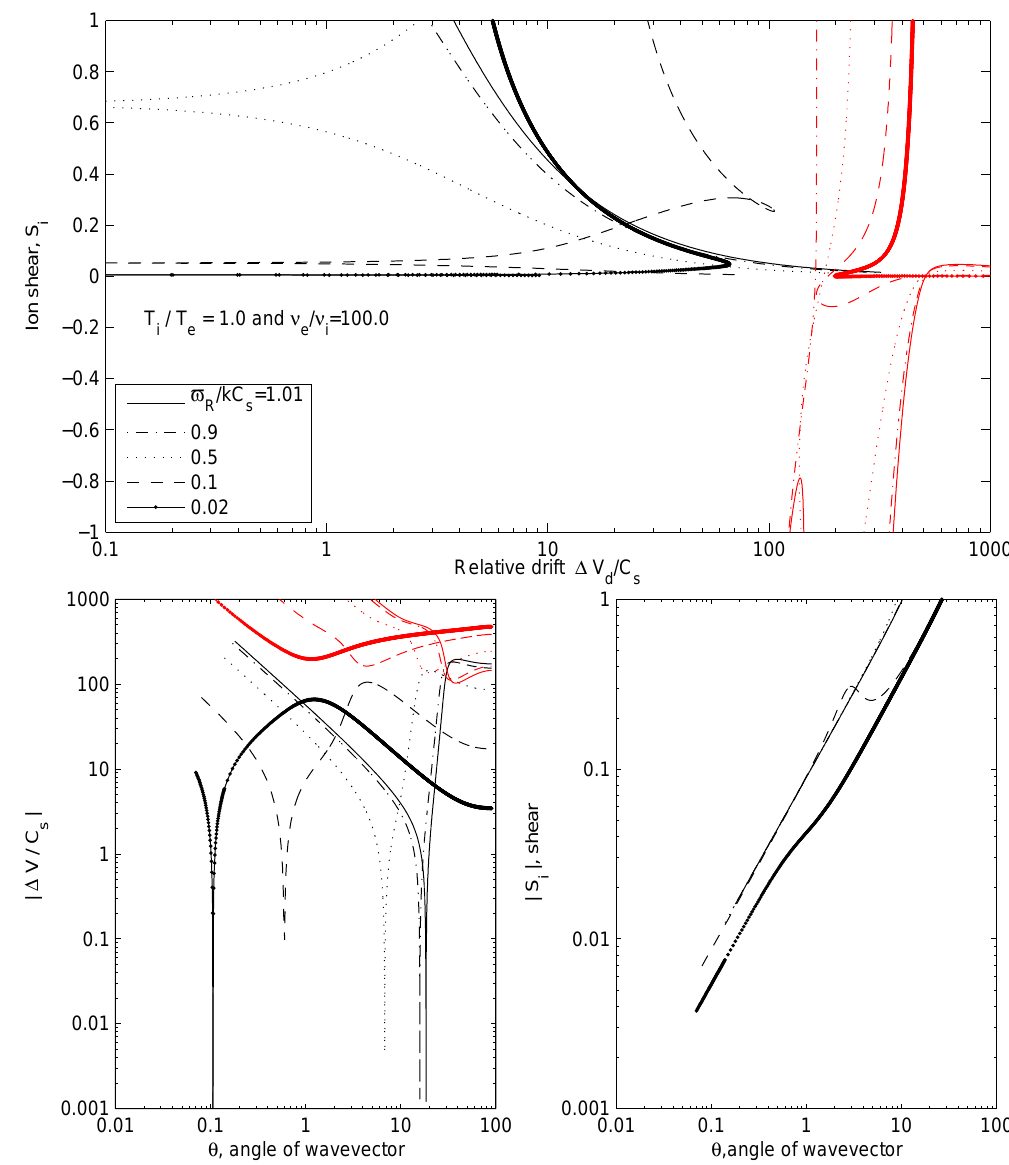
Fig. 6. Threshold conditions for ν e /ν i = 100 . 0 and τ = 1 . 0 using the generalized kinetic dispersion relation. The top panel shows the shear S i versus the relative drift 1V d /C s . The bottom left panel shows the relative drift as a function of angle. The bottom right panel shows the velocity shear as a function of angle. The line scheme is the same as in Fig.